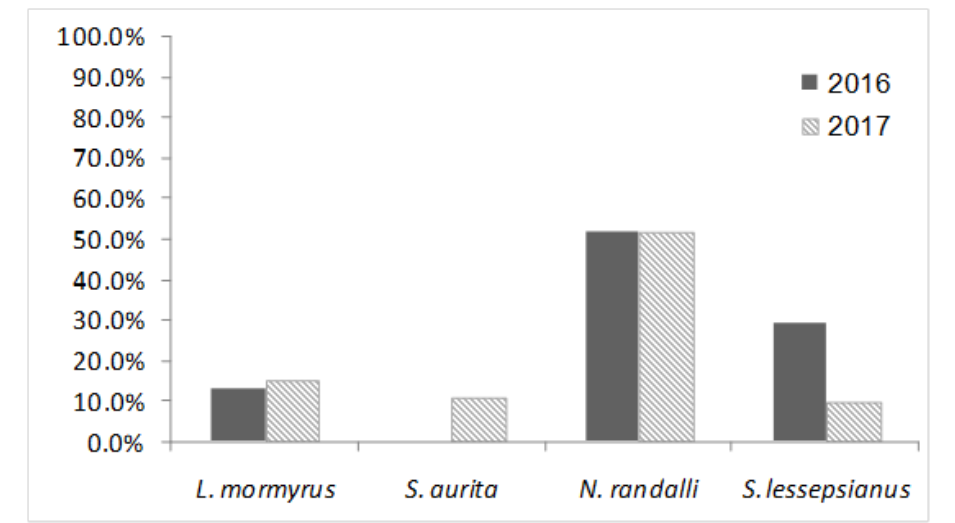
Figure 1. Percentage of NNV positive in the sampled wild fish species. For each species, the results in 2016 and 2017 are presented. No significant difference was found between the sampled years per each species (Chi-Square test of independence, p > 0.05).